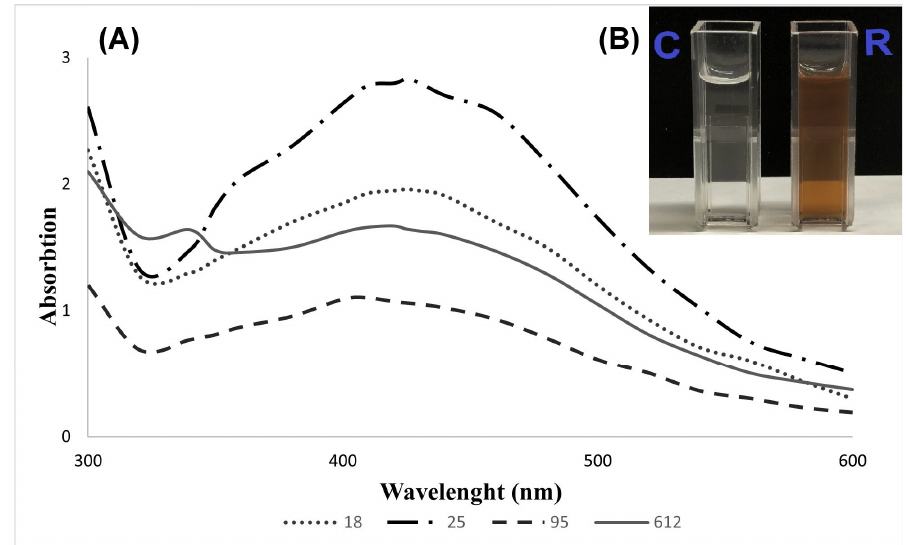
Figure 1. UV–visible spectrum analysis of AgNPs originating from secretomes of Geobacillus spp. 18, 25, 95, and 612 treated with 2 mM AgNO 3 after 48 h incubation at 55 °C ( A ). 18— Geobacillus sp. 18; 25— Geobacillus sp. 25; 95— Geobacillus sp. 95; 612— Geobacillus sp. 612. Color change of a reaction using the Geobacillus sp. 612 secretome ( B ). R—reaction mix; C—control.